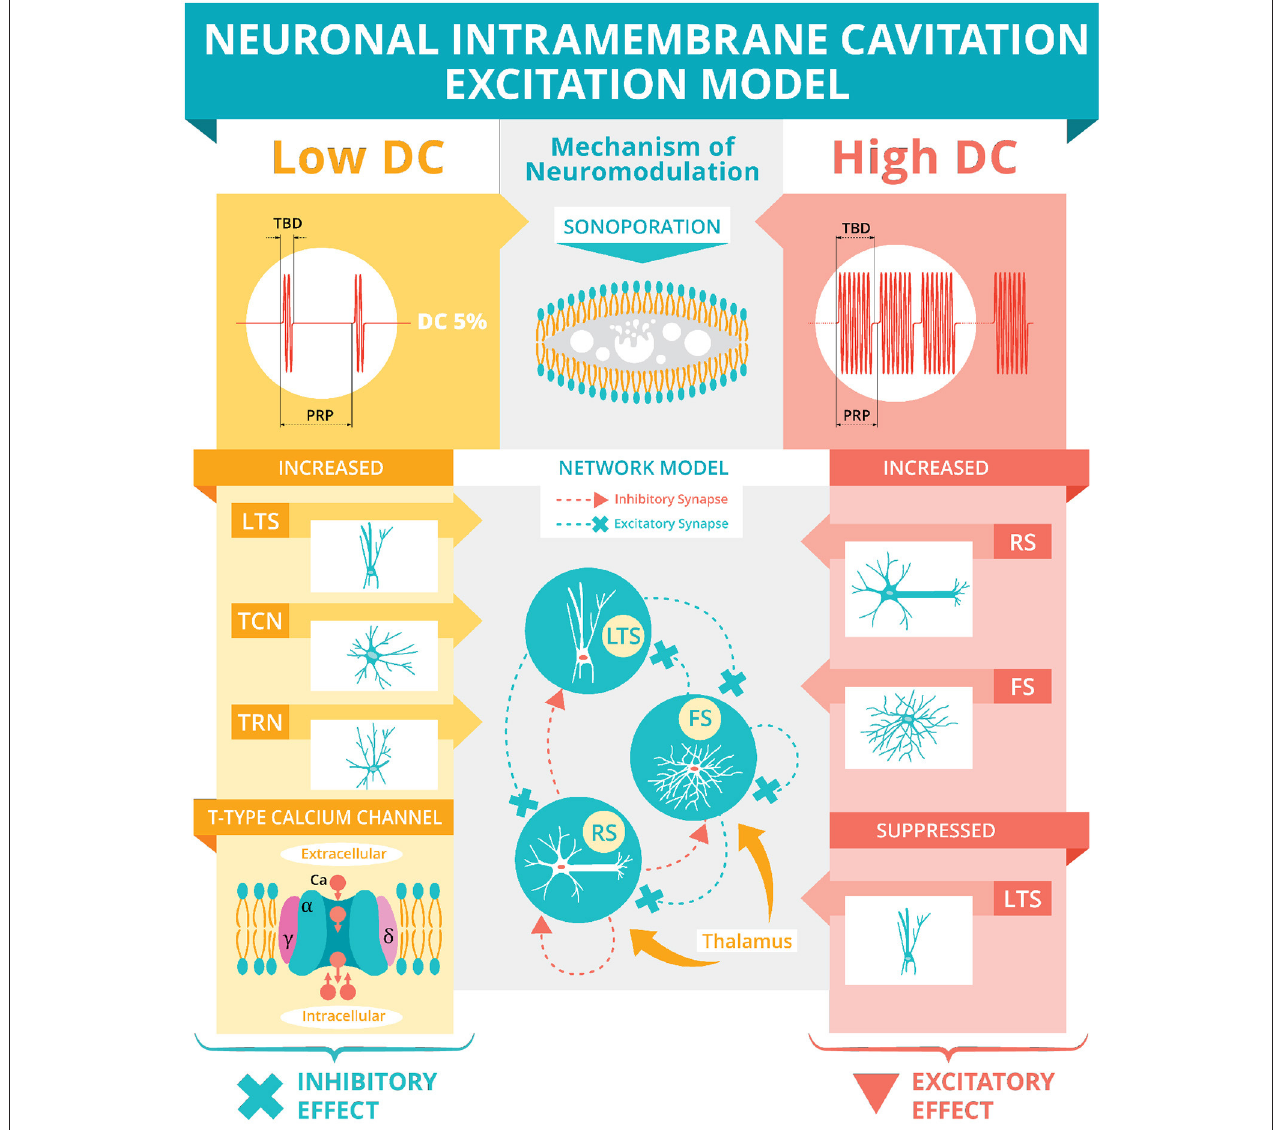
FIGURE 3 | Neuronal intramembrane cavitation excitation model. Plaksin et al. (2014, 2016) proposed the NICE model hypothesizing sonoporation (see Section above and Figure 2F ) as US’s mechanism of neuromodulation. The US’s DC (see Figure 1E ) determines the polarity of neuromodulation. A low DC (i.e., below 5%) during a stimulation’s off-periods will preferentially activate thalamic reticular neurons (TRN), thalamocortical neurons (TCN), and low-threshold spiking (LTS) interneurons via T-type voltage-gated calcium channels (see Section above for full description) producing an inhibitory effect. A high DC (i.e., over 20%) during the on-periods will preferentially activate regular spiking (RS) pyramidal cells and fast spiking (FS) interneurons while suppressing the LTS interneurons producing an overall excitatory effect. This excitatory effect is simulated using a basic network model of LTS, FS, and RS neurons connected with excitatory and inhibitory synapses and thalamic inputs. The network model predicts an optimum excitation of 70%